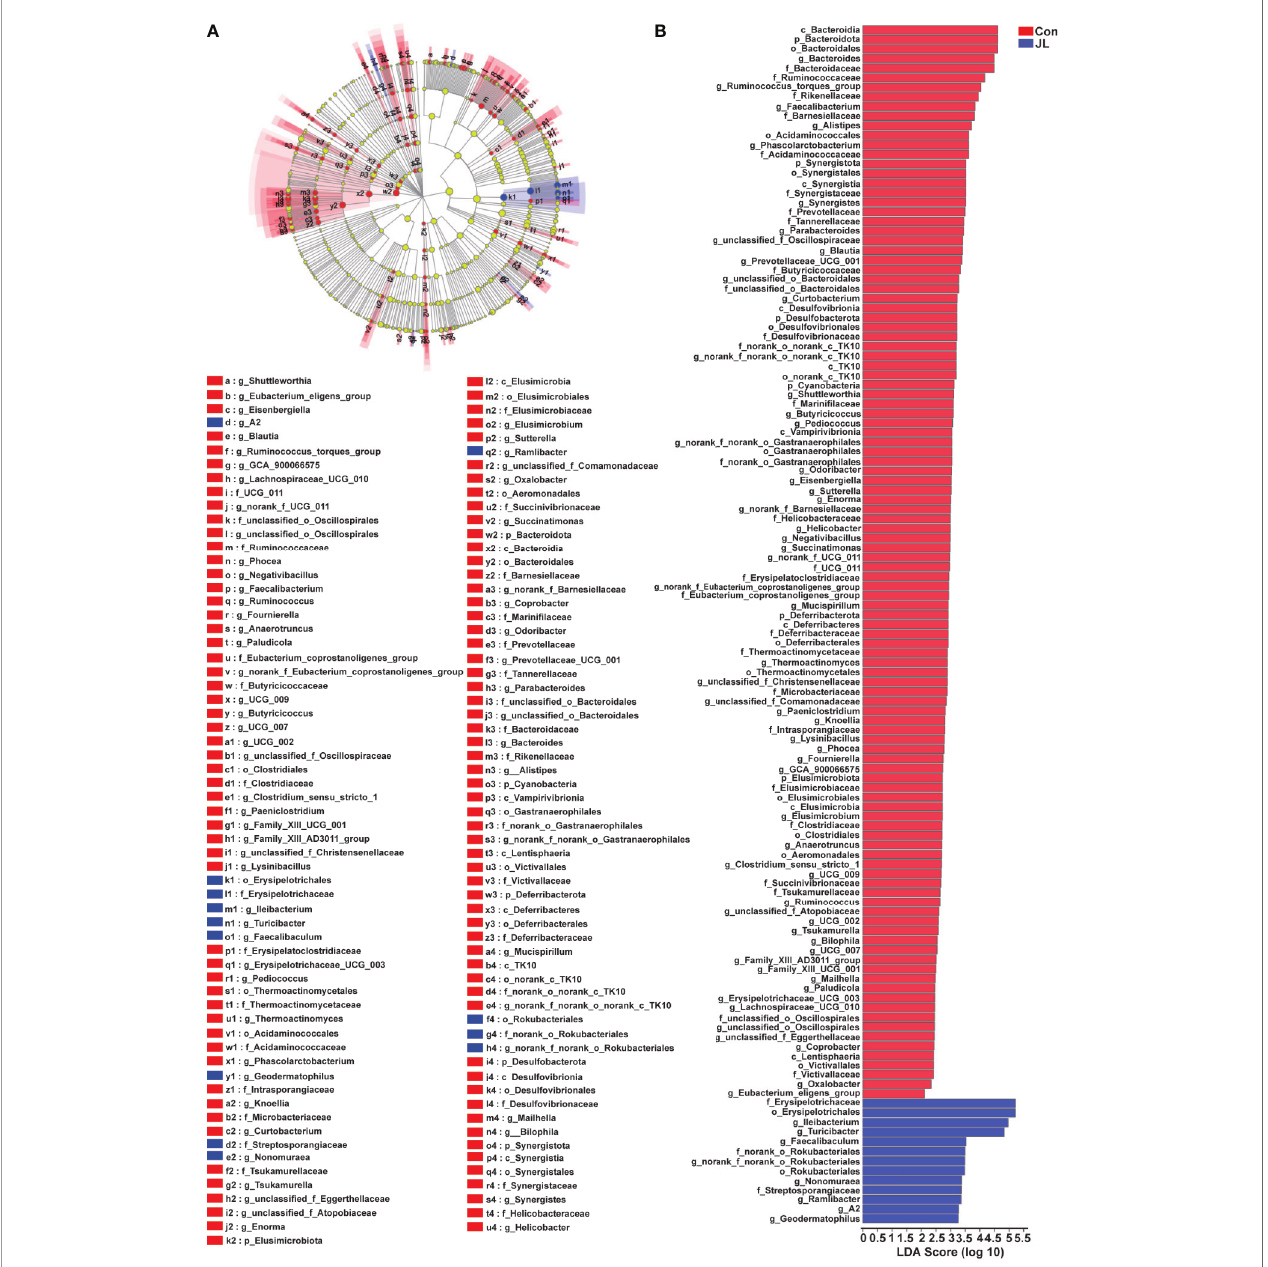
FIGURE 6 | LEfSe analysis of jejunal microbiota in Con (n = 6) and JL (n = 5) groups. (A) Taxonomic cladogram obtained from LEfSe analysis. The different taxon was assessed by non-parametric factorial Kruskal-Wallis (KW) sum-rank test. Different taxa are highlighted by colored circles and shaded areas. The diameter of each circle re fl ects the abundance of that taxa in the community. (B) Taxa with a different abundance in the jejunal microbiota between Con or JL groups. A cut ‐ off value ≥ 2.0 was used for the linear discriminant analysis